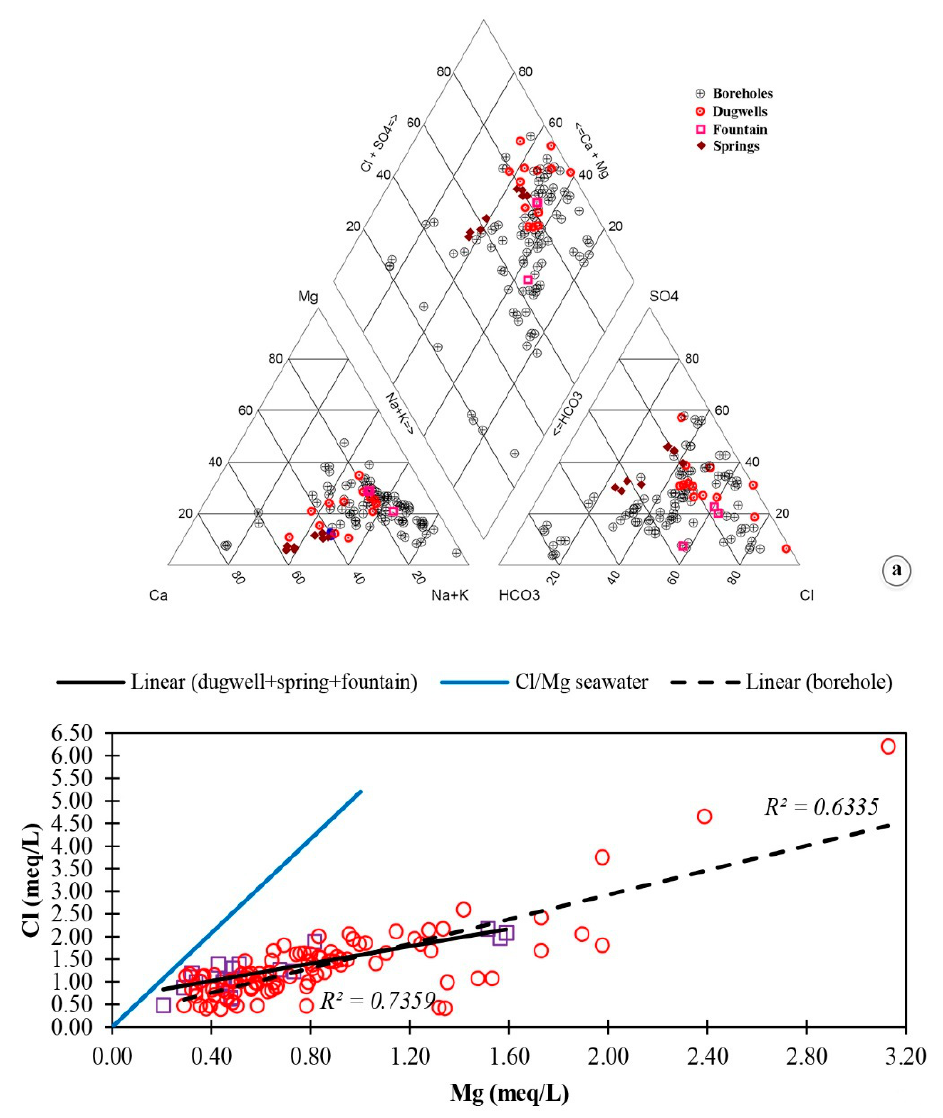
Figure 3. Cont Figure 3. Hydrochemical and isotopic relationships for groundwater samples collected during the three fieldwork campaigns. ( a ) Piper diagram; ( b ) Scatter diagrams for several hydrochemical parameters, R-squared value ( R 2 ) is indicated for each studied linear relationship, and seawater relations are those reported by [85]; ( c ) The average chemical composition of Porto precipitation, reported by [98] and [99]; ( d ) δ 18 O vs. δ 2 H signatures of the studied groundwater samples. The global meteoric water line (GMWL) ( δ 2 H = 8 δ 18 O + 10, [89]), the local (Porto meteorological station) meteoric water line (LMWL) ( δ 2 H = (6.20 ± 0.33) and δ 18 O + (1.12 ± 1.16), r = 0.93, [93]), and the long-term mean isotopic composition of Porto precipitation (Prec. Porto) ( δ 2 H = − 26.9 ‰ and δ 18 O = 4.54 [93]) were plotted as reference.